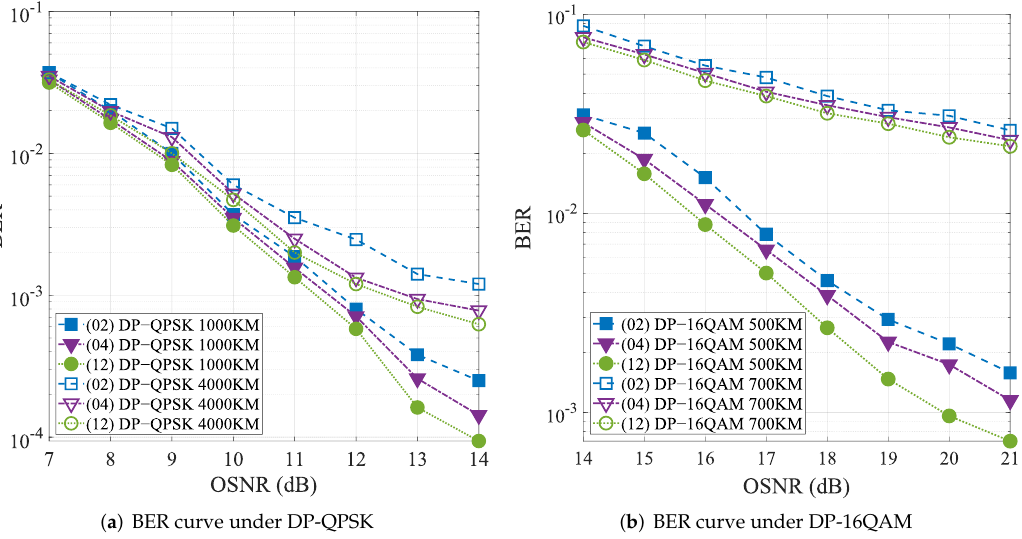
Figure 5. The BER performance of the DP-QPSK and DP-16QAM data. We compare the TD-CDE FIR filter, FD-CDE FIR filter, and WO-TD-CDE FIR filter under different OSNR. ( a ) Under the DP-QPSK modulation format, the fiber transmission distance is 1000 km and 4000 km, respectively. ( b ) Under the DP-16QAM, the fiber transmission distance is 500 km and 700 km,